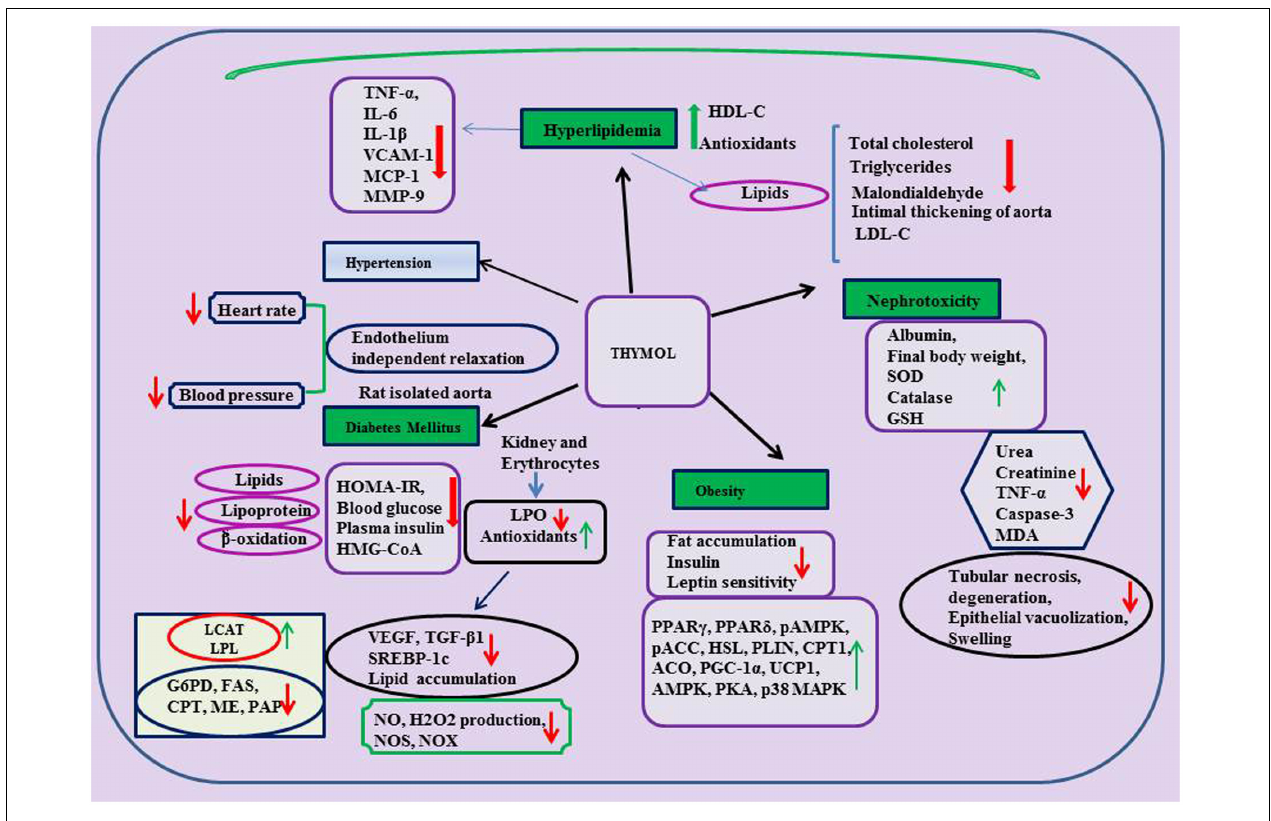
FIGURE 4 | Effect of thymol on metabolic and kidney